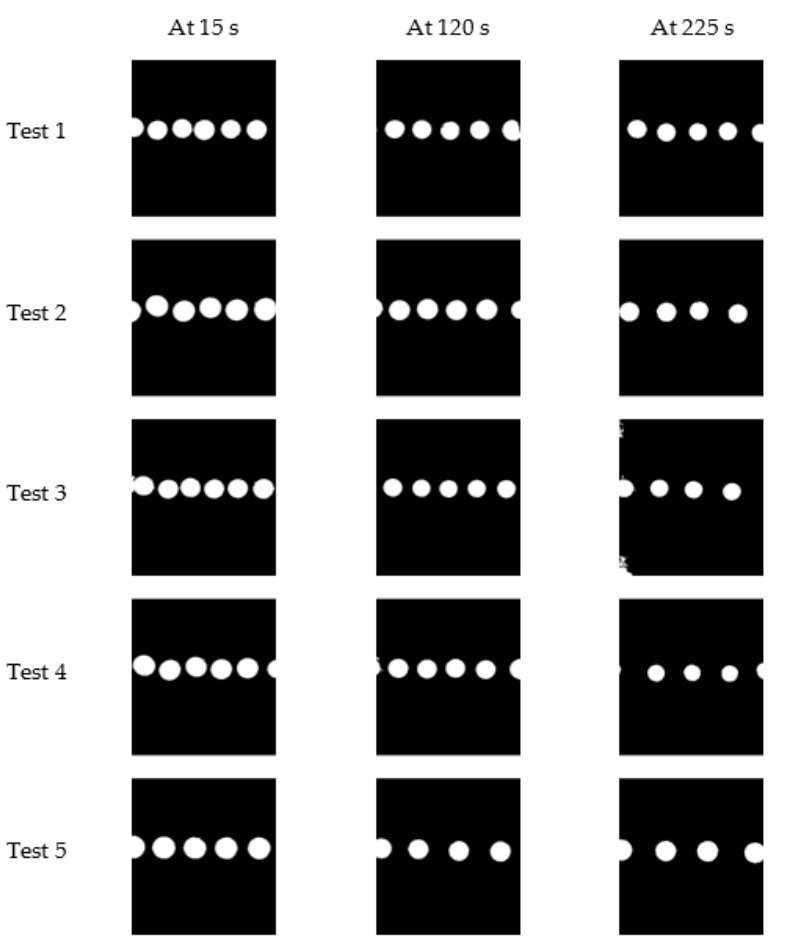
Figure 14. First, middle, and last image of each experiment.